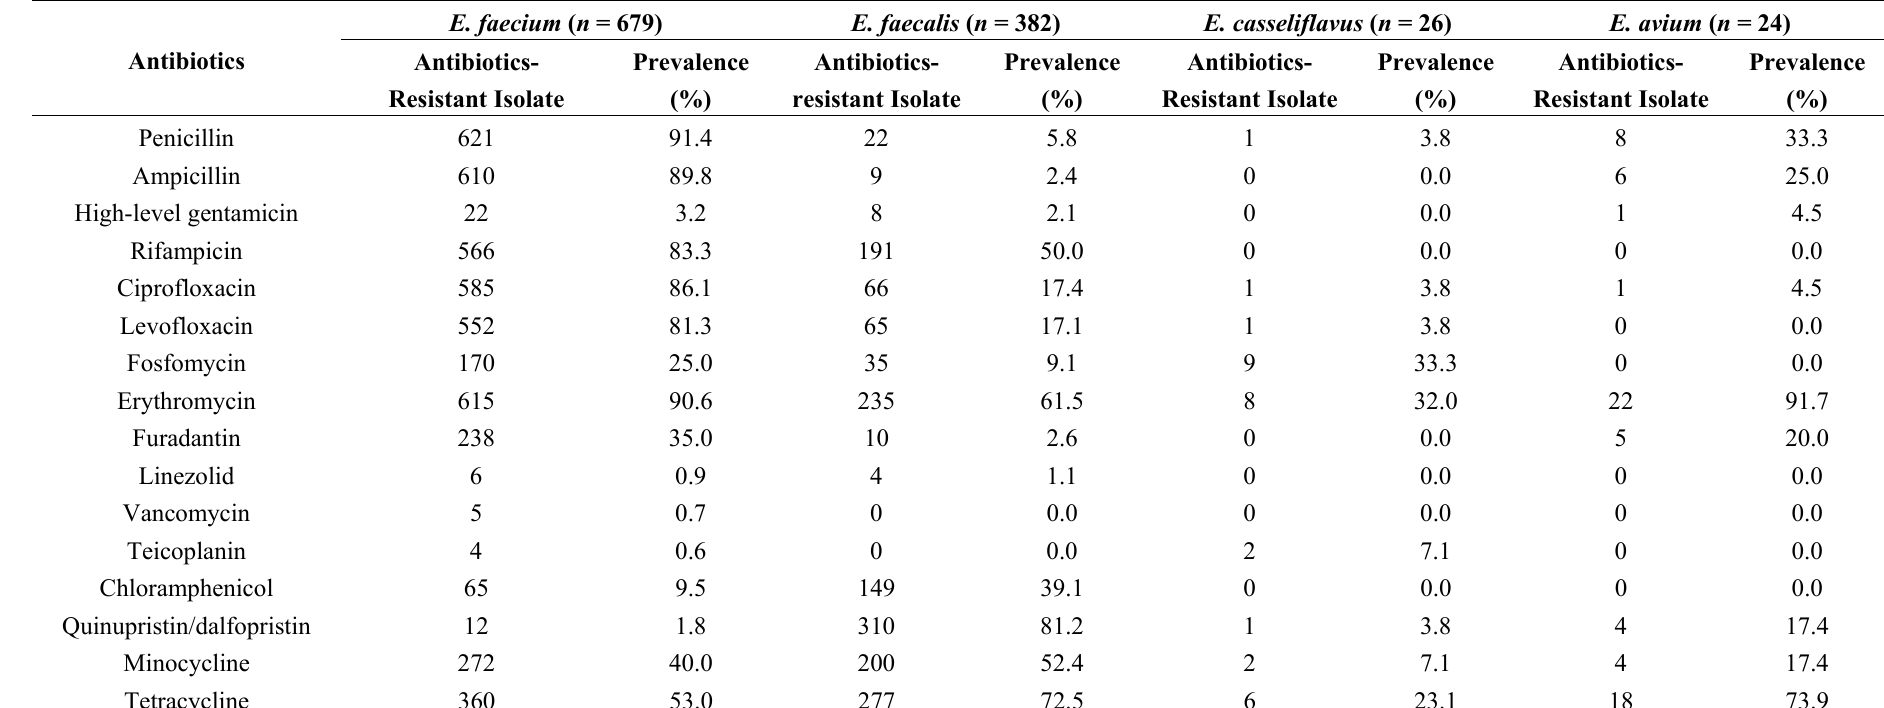
Table 5. Antimicrobial resistance in Enterococcus